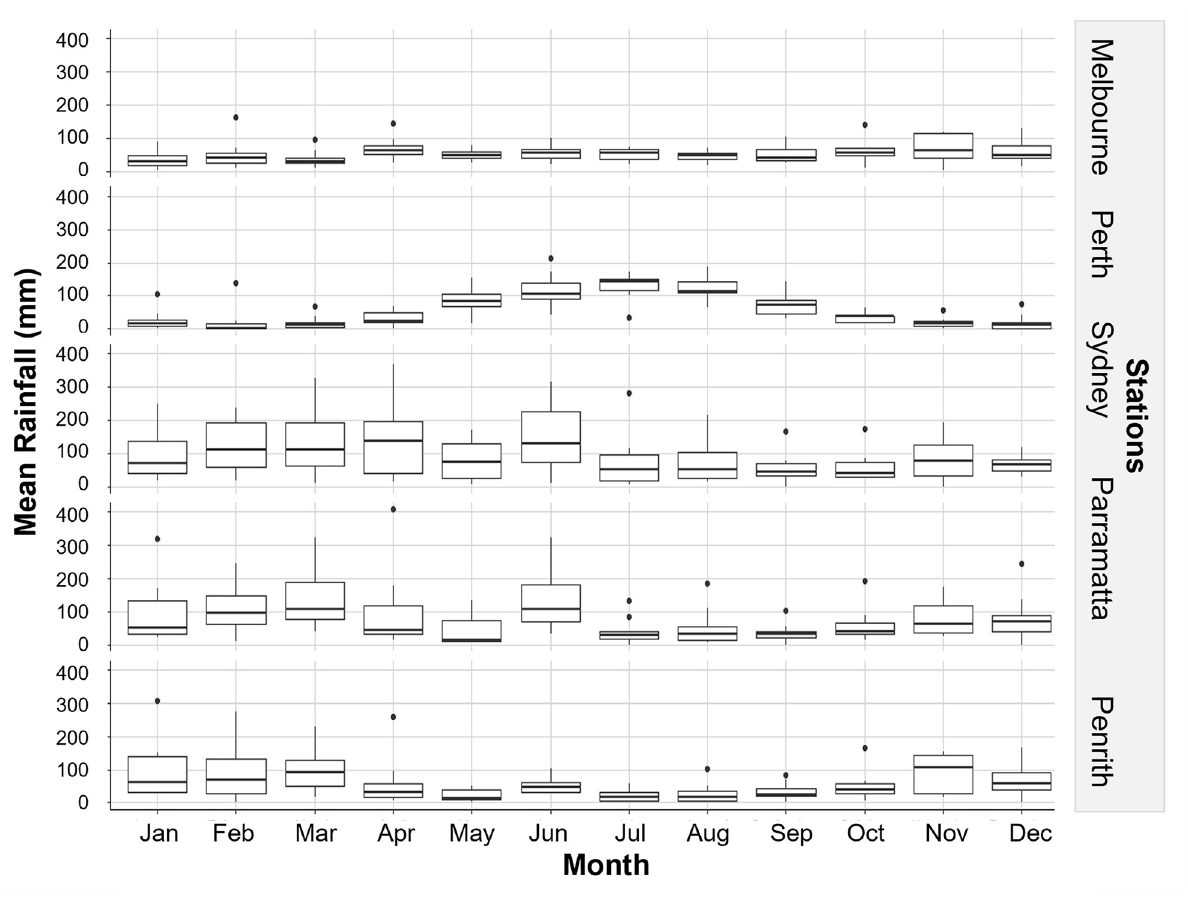
Fig 8. Trend in rainfall between 2009–2019 at sampling